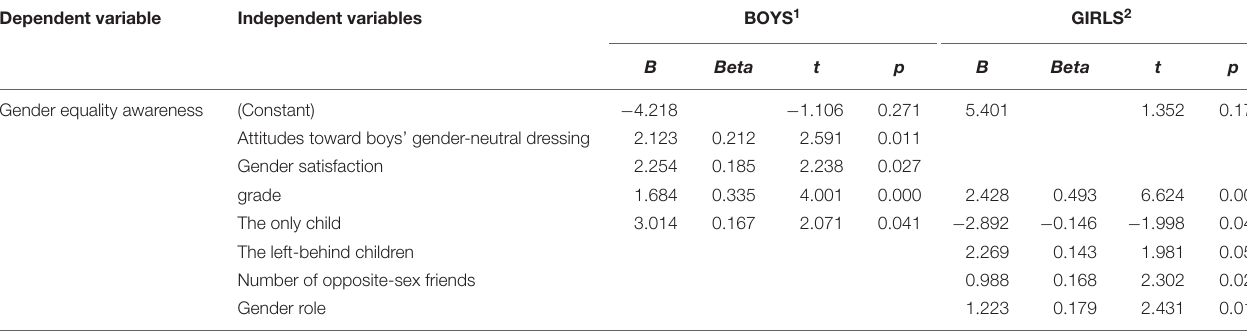
TABLE 5 | Multiple linear stepwise regression analysis of the study variables on gender equality awareness among boys and girls.